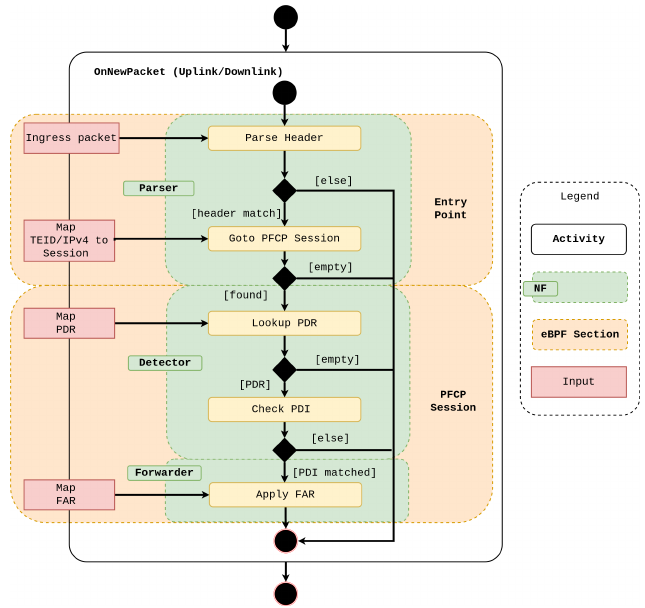
Figure 9. Workflow in Datapath Layer (version